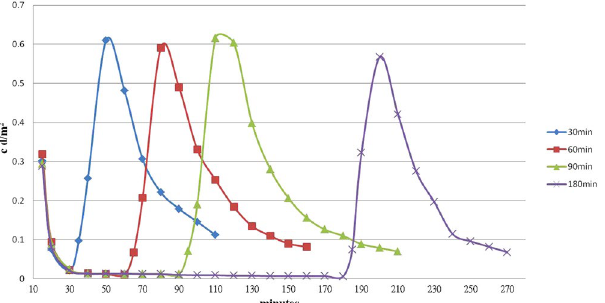
Figure 8. TL-time plot showing four curves that represent tests performed with an initial excitement at 90 °C, then 10 minutes later after ending excitation their temperatures were lowered to 0 °C for 30, 60, 90, and 180 minutes respectively before increasing the temperature back to 90 °C.